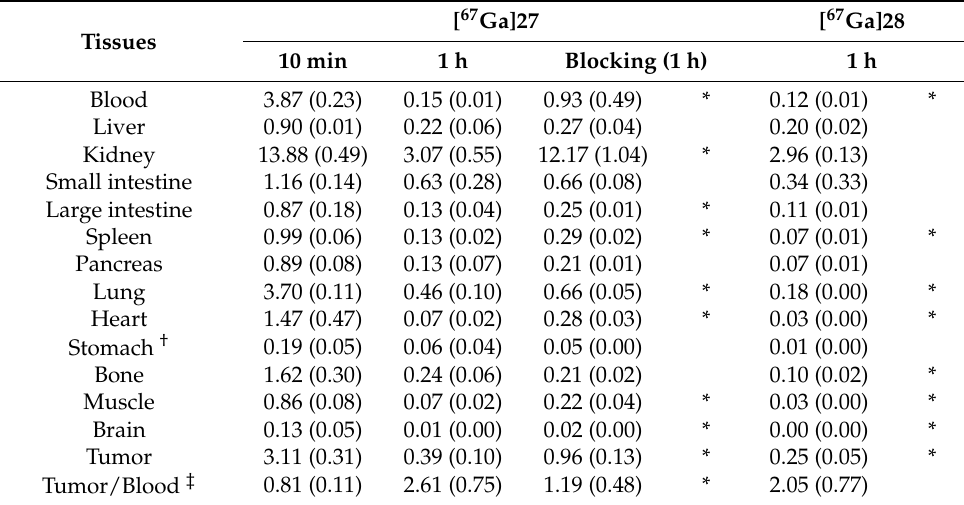
Table 4. Biodistribution of [ 67 Ga]Ga-DOTA-EG 2 -IPLPPPRRPFFK ([ 67 Ga] 27 ) at 10 min and 1 h post- injection and [ 67 Ga]Ga-DOTA-EG 4 -IPLPPPRRPFFK ([ 67 Ga] 28 ) at 1 h after i.v. injection in BxPC3- luc tumor-bearing